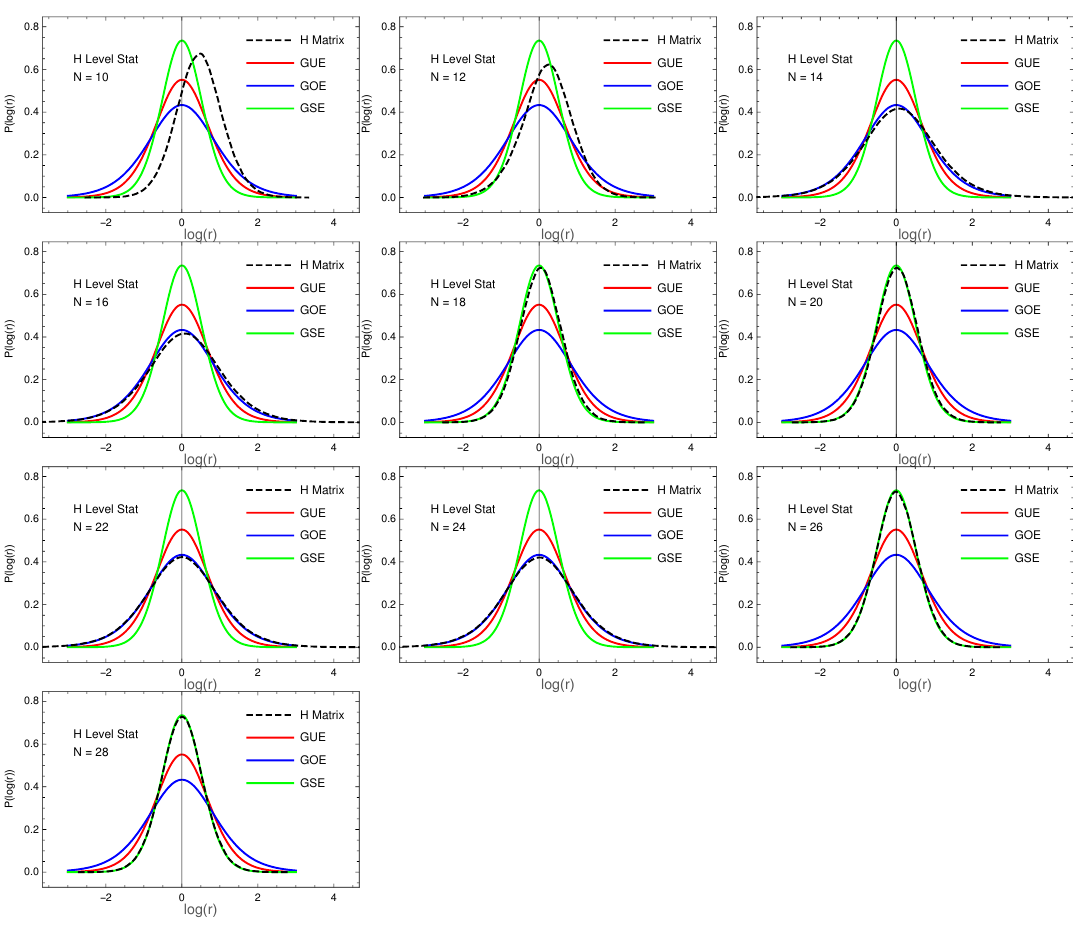
Figure 3 . The nearest-neighbor level spacing distribution for hamiltonian of N = 1 supersymmetric SYK model for di(cid:11)erent N . The lower (blue), middle (red) and higher (green) curves are theoretical predictions of Wigner surmises from GOE, GUE and GSE respectively. The black dashed curves are distributions for all r s from a large number of